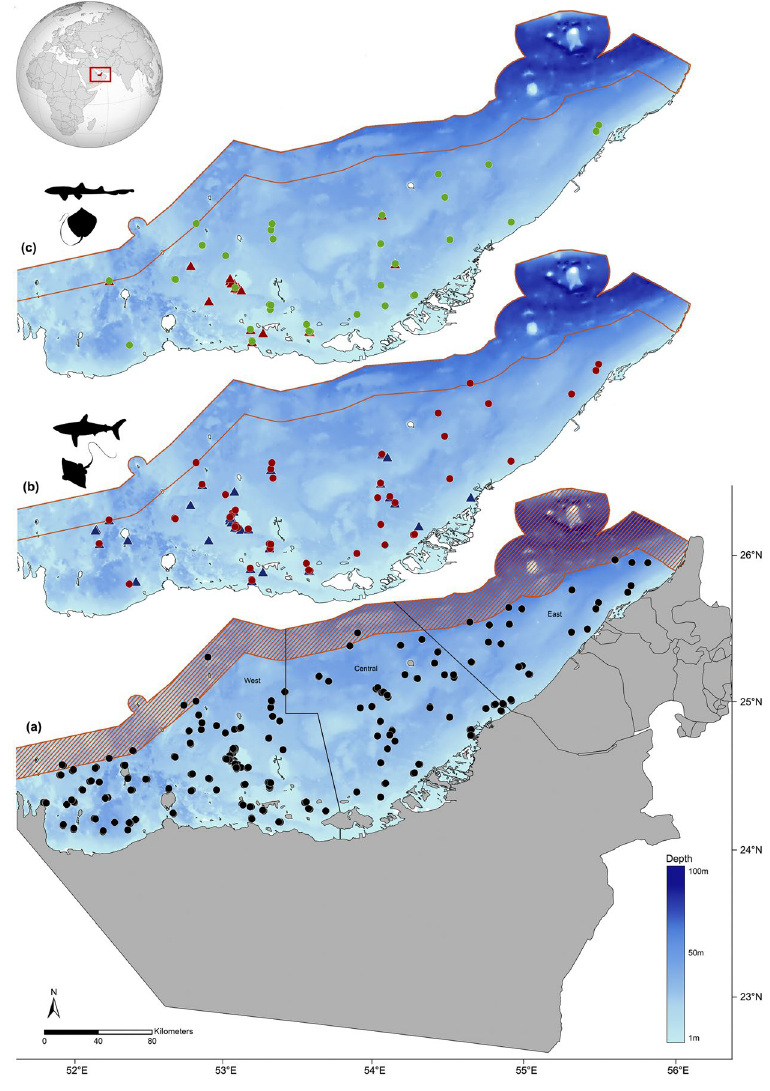
Figure 1. Map of the United Arab Emirates showing locations of ( a ) stations (n = 278) where baited remote underwater video surveys were deployed = ● , ( b ) location of shark = and ray = sightings, and ( c ) location of Arabian carpetshark Chiloscyllium arabicum = and stingray Himantura spp. =